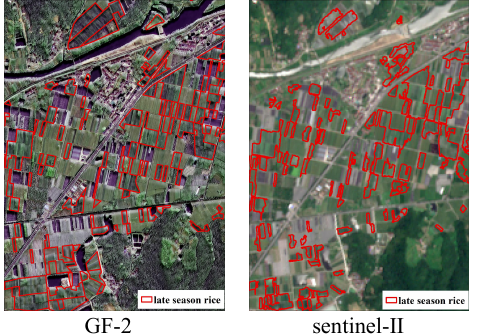
Figure 8. Comparison of GF-2 and sentinel-Ⅱ (the same scale)